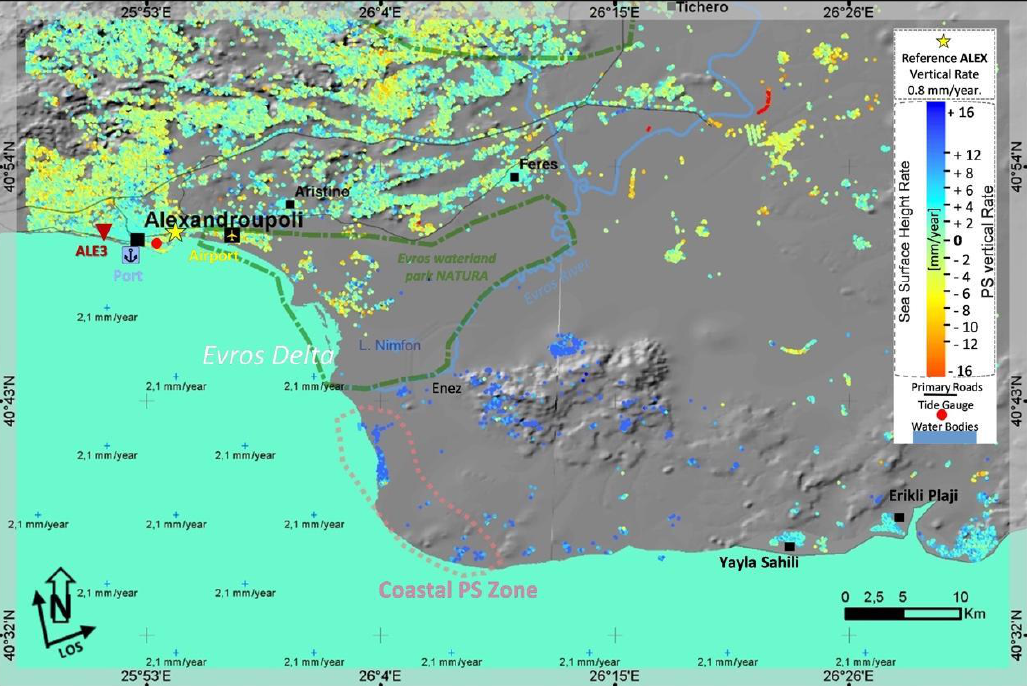
Figure 4. Permanent scatterers’ time series of the coastal area (bounded by a red dashed polygon in Figure 3), mean vertical deformation values and the linear trend.